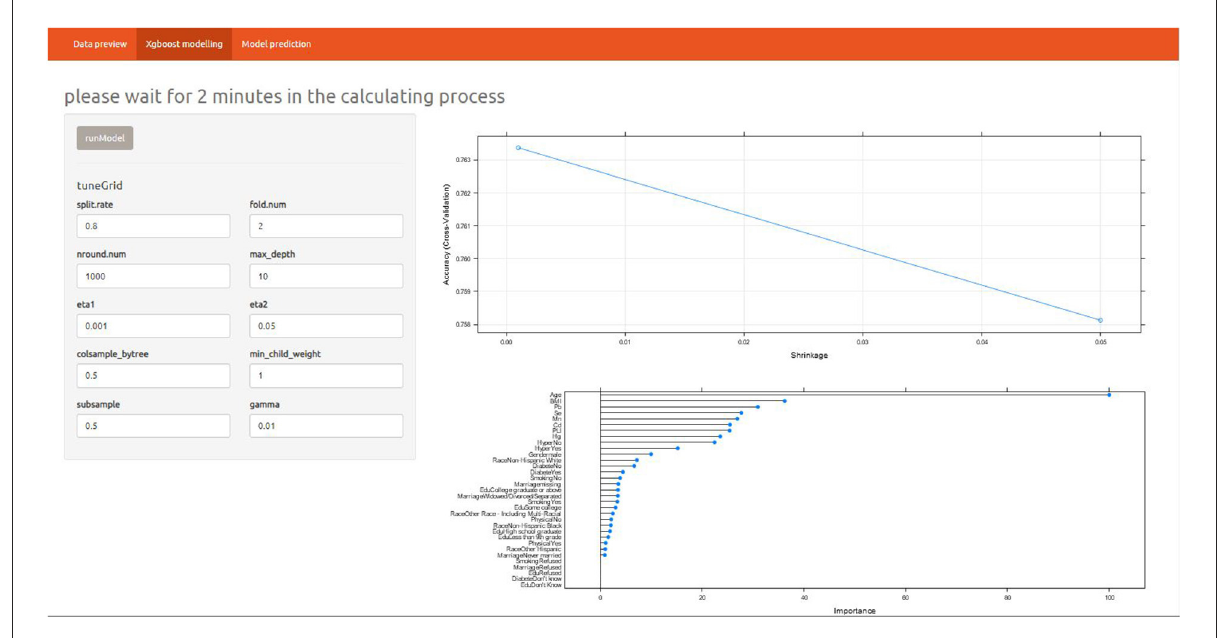
FIGURE3 Introduction of online shiny in XGBoost model